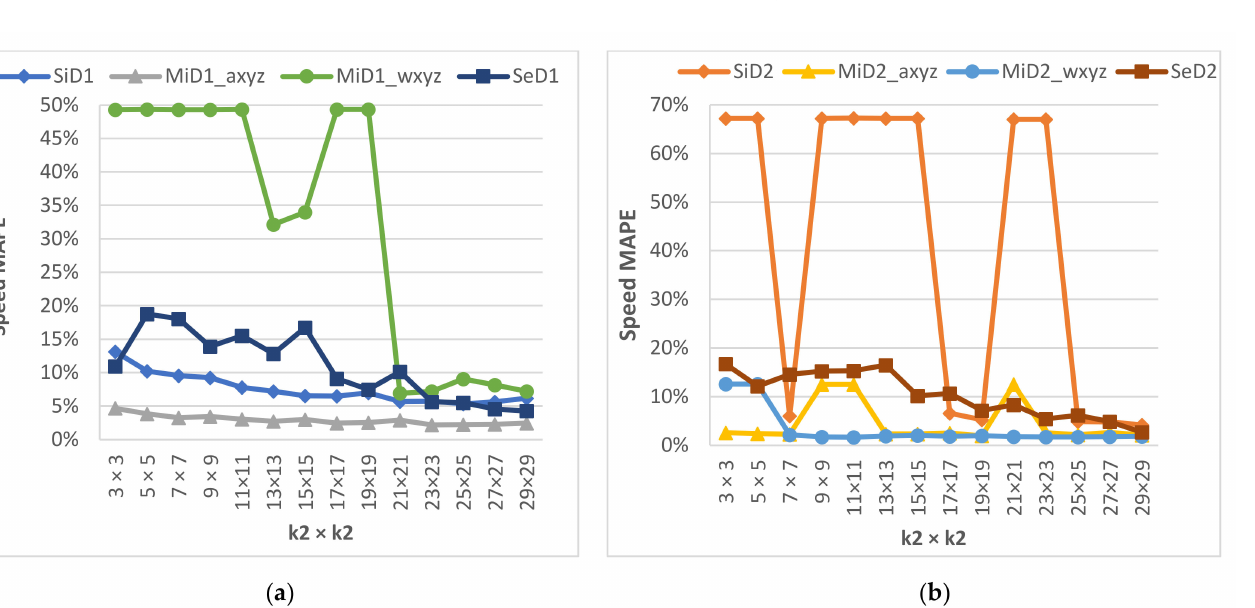
Figure 10. MAPE trends for speed prediction of the architectures type 1 and type 2 with convolutional blocks k1 ≤